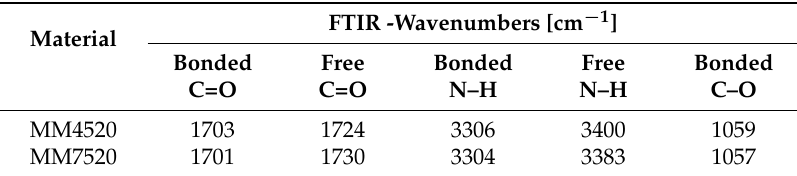
Table 2. Bonding frequencies for dry materials.